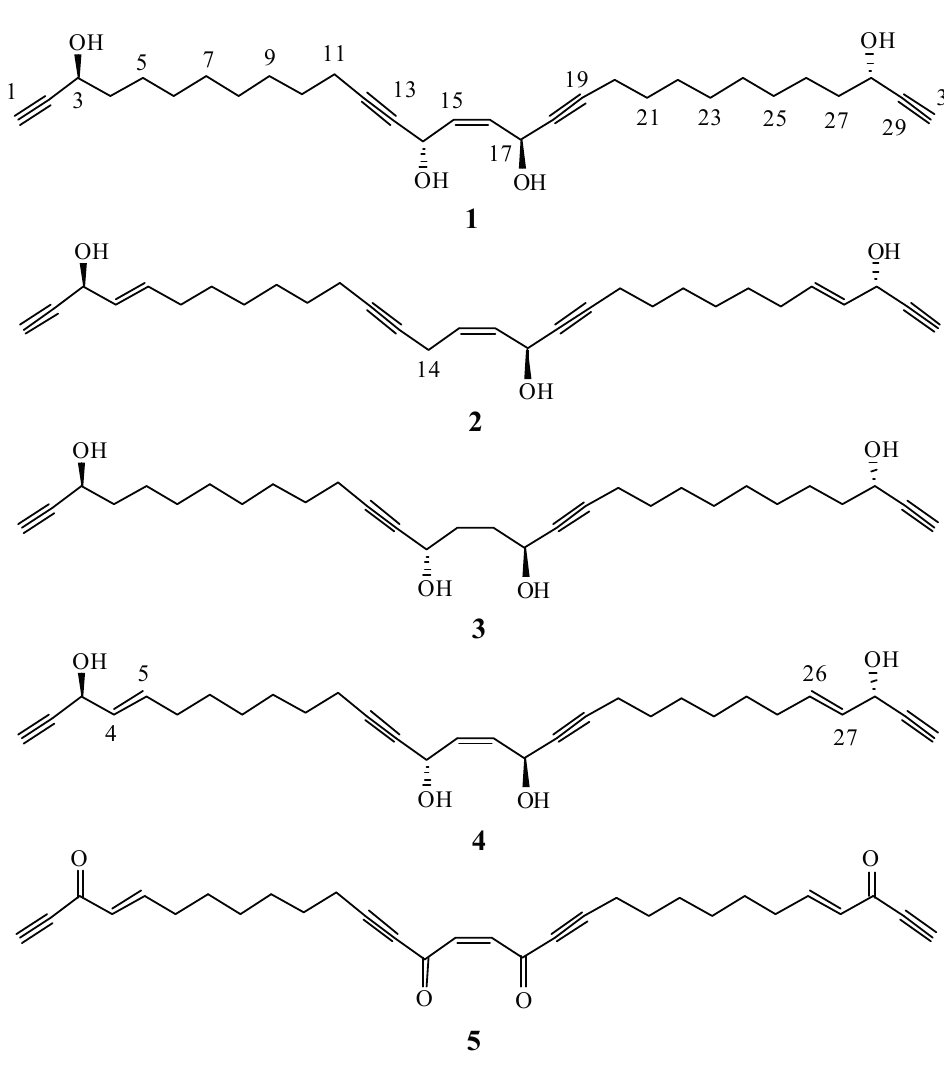
Figure 2. Structures of the isolated metabolites 1 – 5